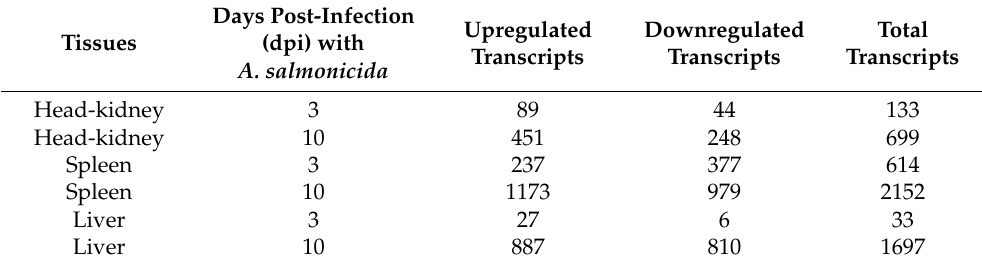
Table 2. Differentially expressed transcripts (DET) identified by reference transcriptome analysis. Days Tissues